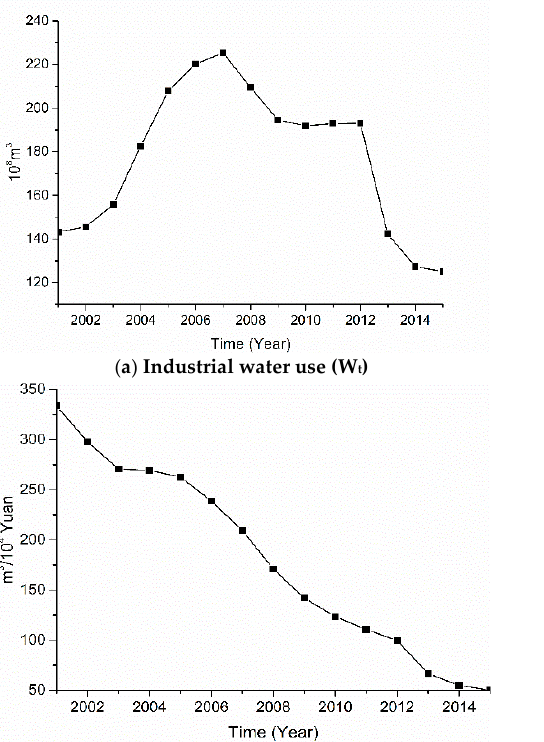
Table 3. Unit root test